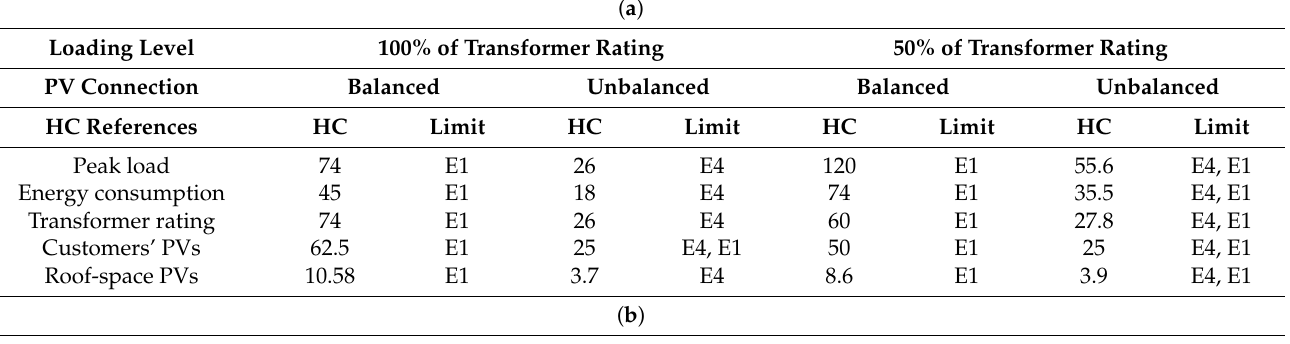
Table 6. HC reference value comparison for two different loading levels of the maximum load as 100% and 50% of transformer rating. ( a ) HC of the rural region for two loading levels; ( b ) HC of the suburban region for two loading levels; ( c ) HC of the urban region for two loading